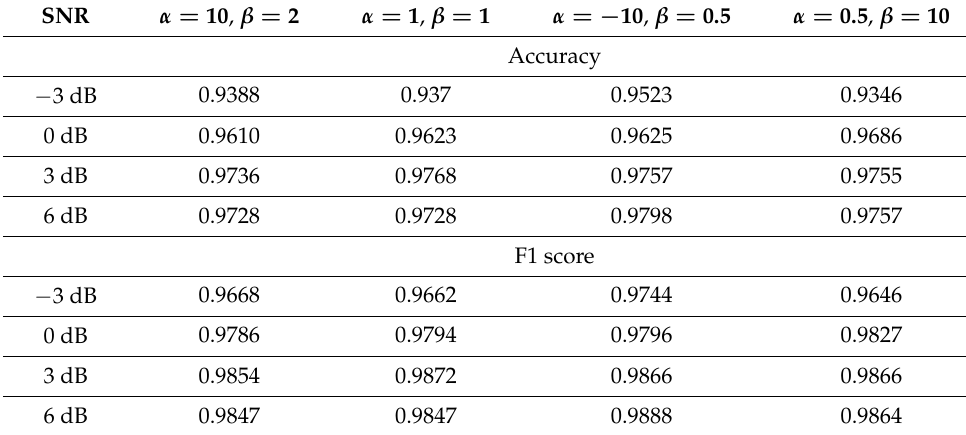
Table 8. Classification results for the first signal with proposed entropy measure and different parameter